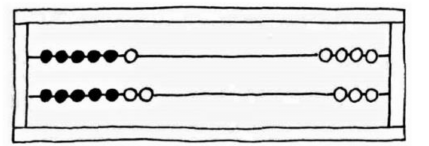
Figure 9. The arithmetic rack in Proeve [40] (p.